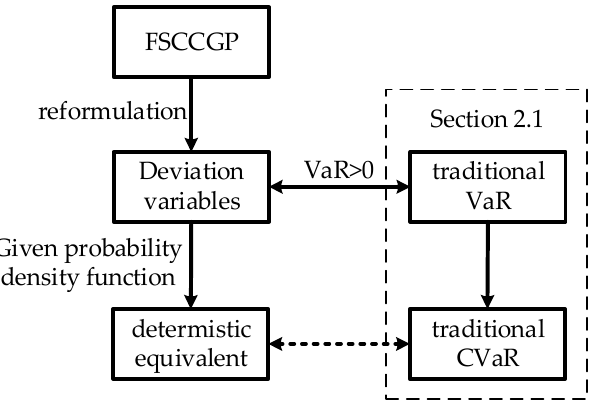
Figure 1. The transformation sequence of FSCVaR.